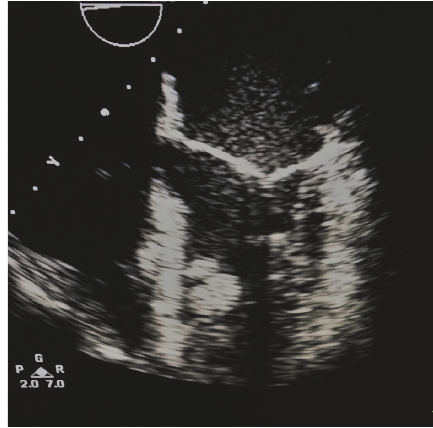
Figure 2: Transesophageal echocardiography showed two pedun- culated thrombi in the left